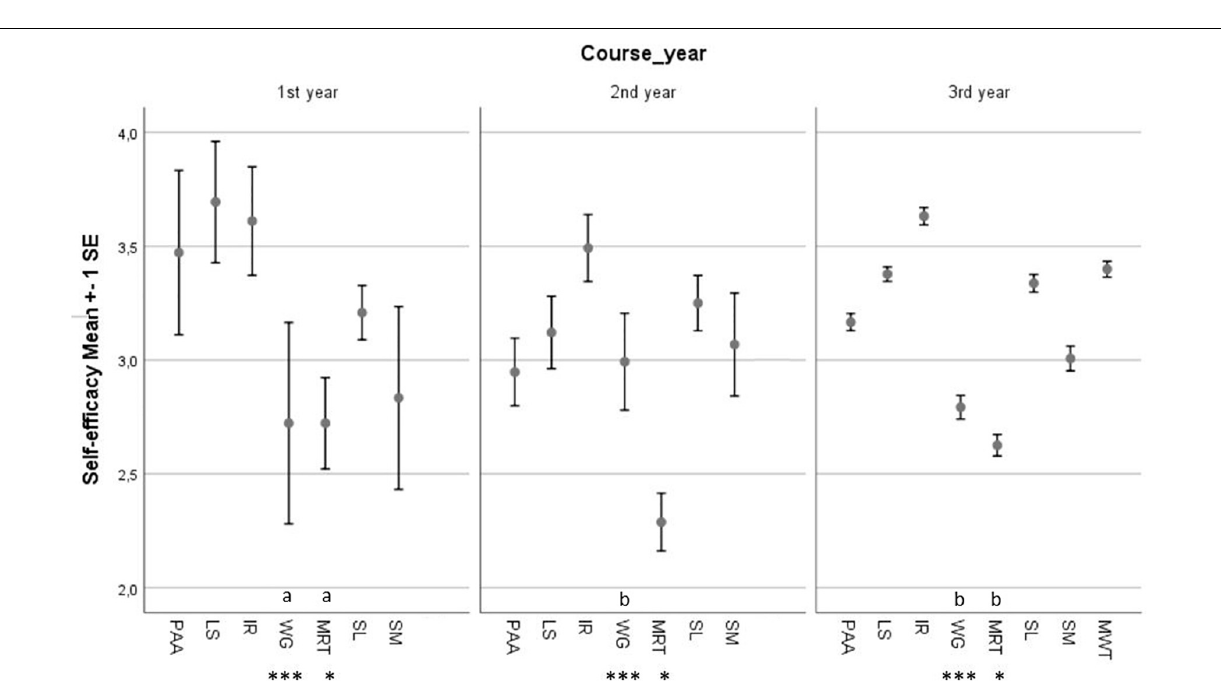
Frontiers in Psychology |